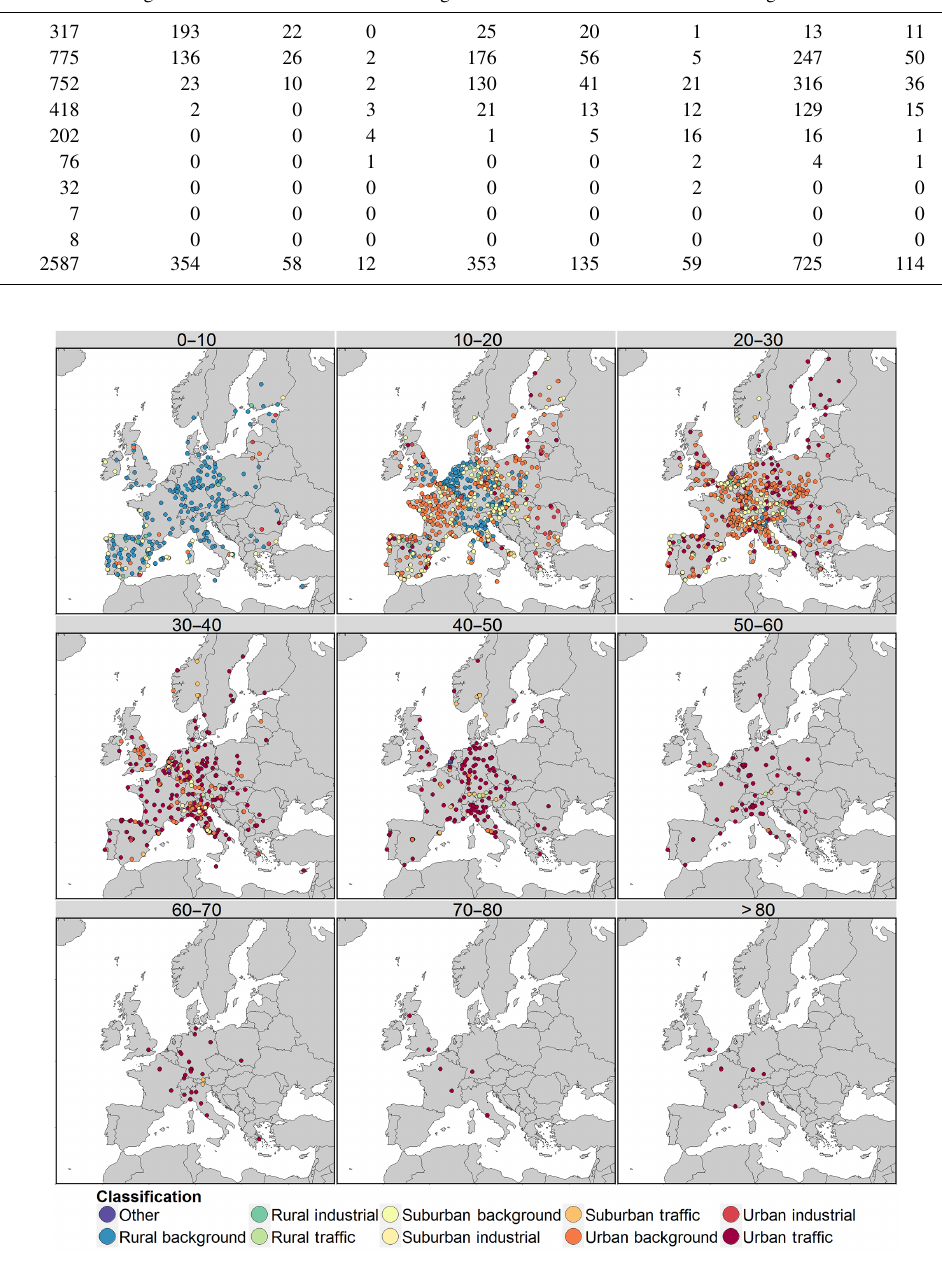
Figure 2. Locations of NO 2 monitoring sites across Europe. Sites are grouped into 10µgm − 3 concentration bins based on 2010–2014 average annual NO 2 concentration, and are coloured according to the EU AirBase site-type